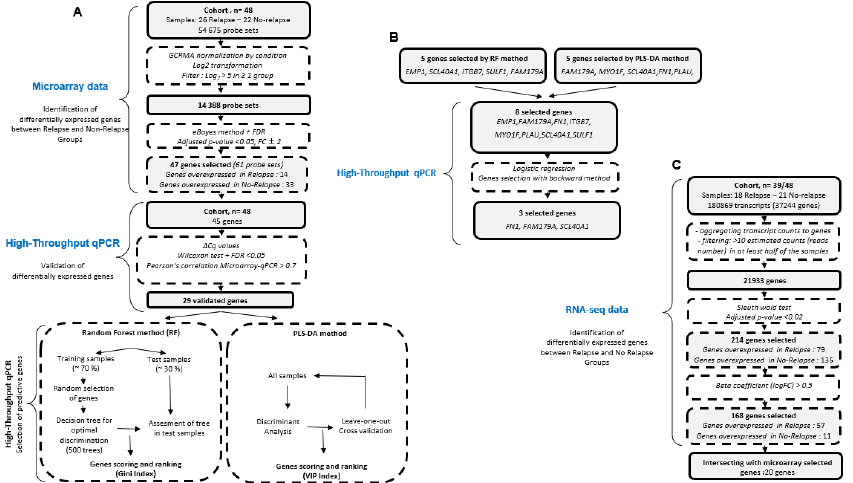
Figure 1. Workflow of development and validation. ( A ): Microaaray data and high- throughput qPCR workflow. ( B ): Gene selection using high- throughput qPCR. ( C ): Identification of differentially expressed gene between relapse and no-relapse groups using RNA sequencing.